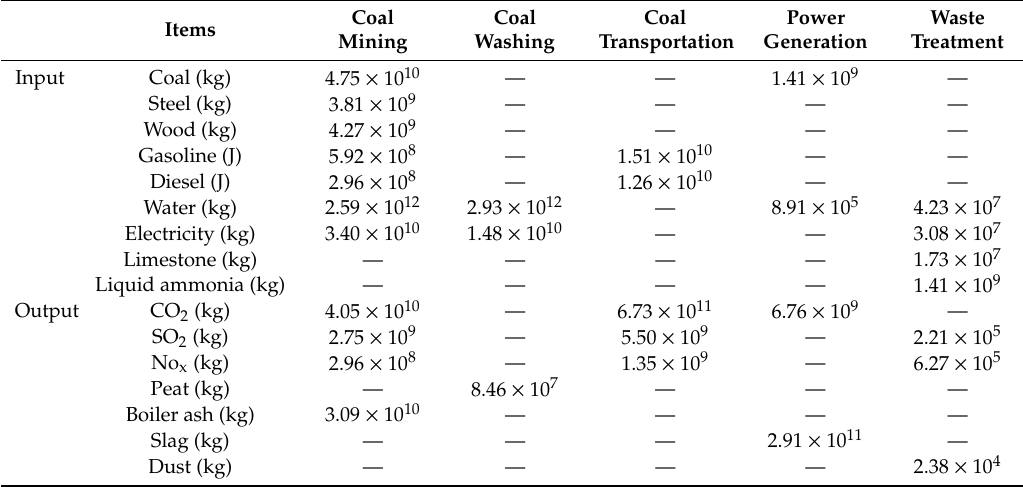
Table 4. Life cycle inventory of a 660 MW coal-fired generating unit (Unit